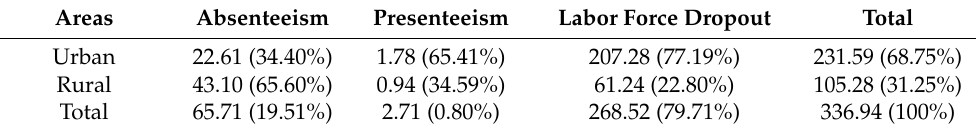
Table 5. Cost of absenteeism, presenteeism, and labor force dropout in 2017 (USD, billion). Areas Absenteeism Presenteeism Labor Force Dropout Total